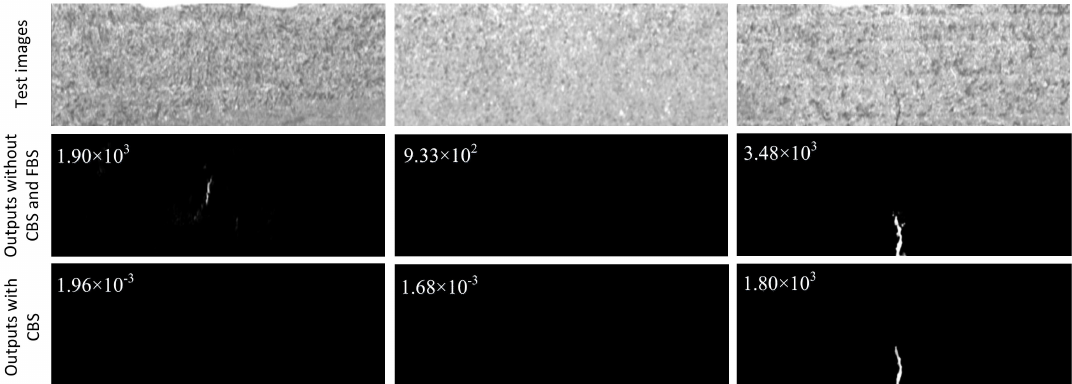
Figure 4. Examples with coarse background suppression or not. Negative, negative, positive samples are shown, respectively, in row 1, while the two images on the left in row 2 signify two kinds of prediction results of negative samples with an obvious false alarm or not, and the figures on the top left denote the scores via our classification